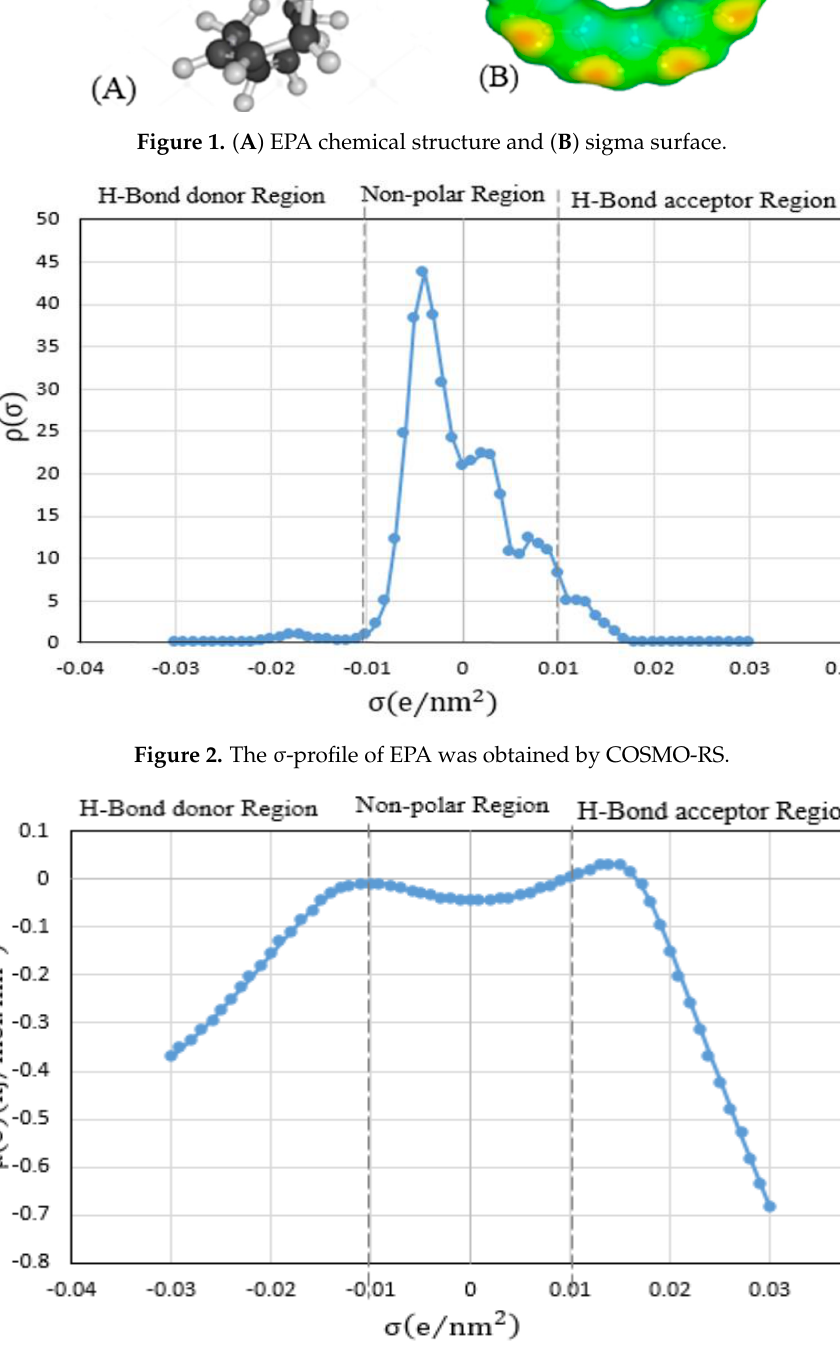
Figure 3. The σ -potential of EPA was obtained by COSMO-RS.